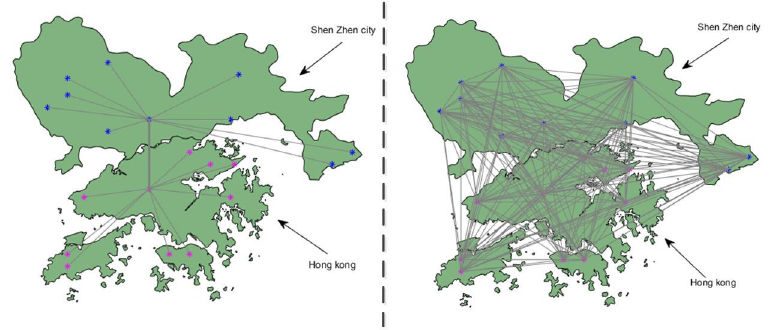
Fig 7. The comparison of banks information flow between Shenzhen city to Hong Kong.